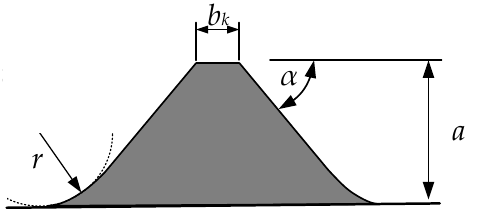
Figure 1. Cross-section of a transversal rebar rib in the center with definition of geometrical parameters according to [17,18].